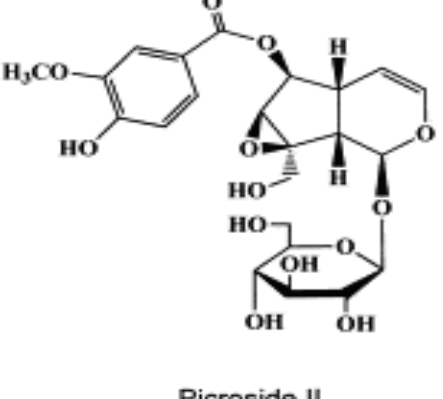
Figure 1. The chemical structure of picroside II ( β - D -glucopyranoside, 1a,1b,2,5a,6,6a- hexahydro-6-[(4-hydroxy-3-methoxybenzoyl)oxy]-1a(hydroxymethyl)oxireno Cyclopenta [1,2-c]pyran-2-yl)